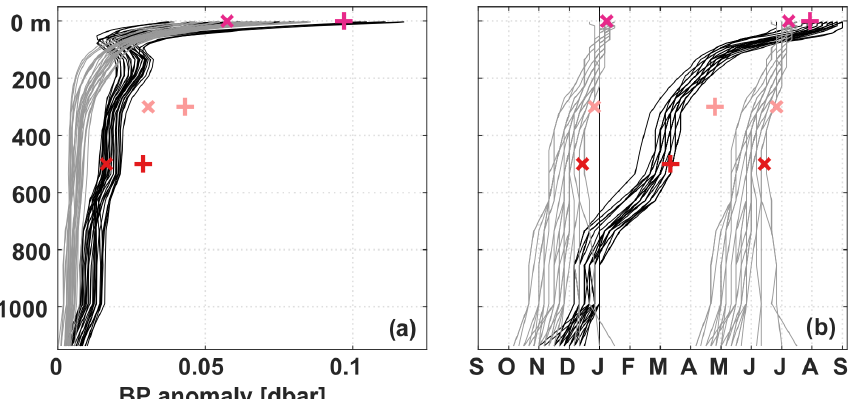
Figure 6. (a) Amplitudes and (b) phases of the minima of the annual (pluses and black curves) and semi-annual (crosses and grey curves) harmonics of the pressure anomalies at the eastern boundary along 11 ◦ S. Markers represent estimates from the observations (2013–2018) at 0, 300 and 500m; the curves show estimates calculated from INALT01 for 5-year windows running through the period of available data